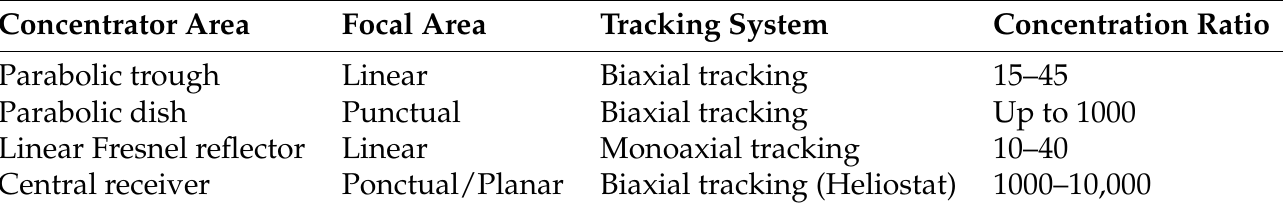
Table 3. Solar Concentrators Characteristics